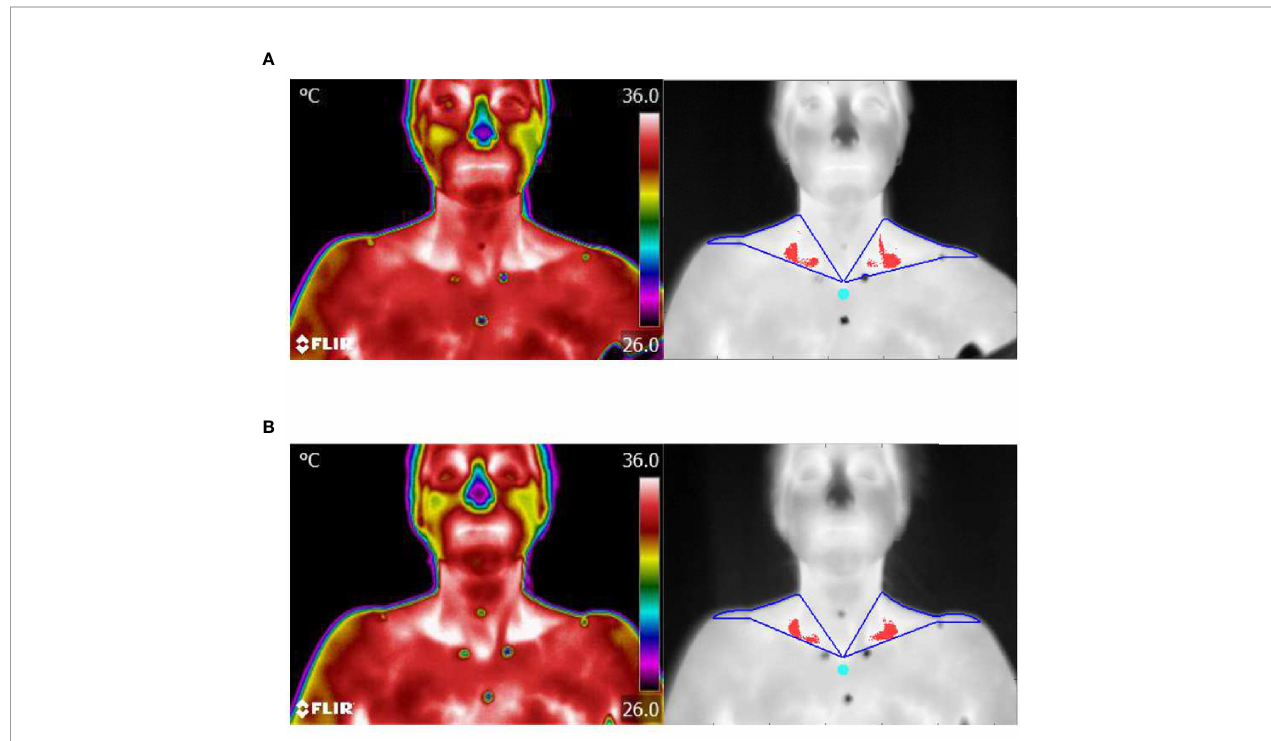
FIGURE 2 | Thermal imaging. (A) Representative example of thermal images of the skin area overlying neck and upper chest during cold stimulation after 12 weeks of LT4 treatment with corresponding images of the contour of ROI (blue) and hottest 10% of pixels (red) identi fi ed in the SCV fossa and sternal reference region (turquoise). (B) Same as for (A) , but after 12 weeks of LT3